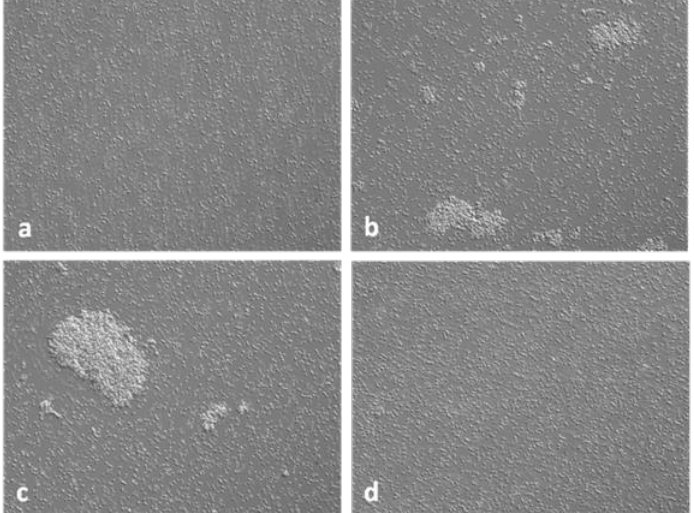
Figure 4. Clumping assays with E. faecalis 543 induced and E. faecalis JH2-2.